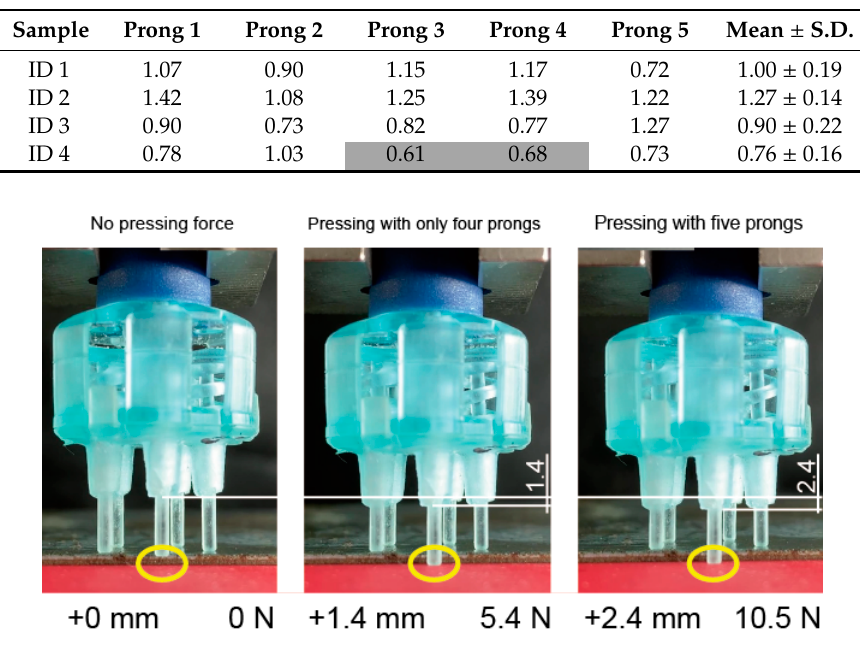
Figure 7. Spring constant of electrode was changed depending on the number of prongs.